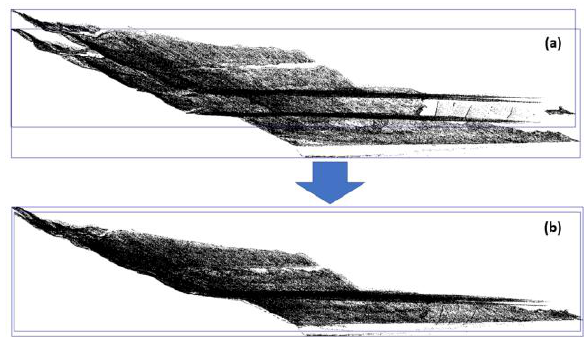
Figure 14. Point clouds registration using MBBC method – (a) before the registration process, (b) after the registration process